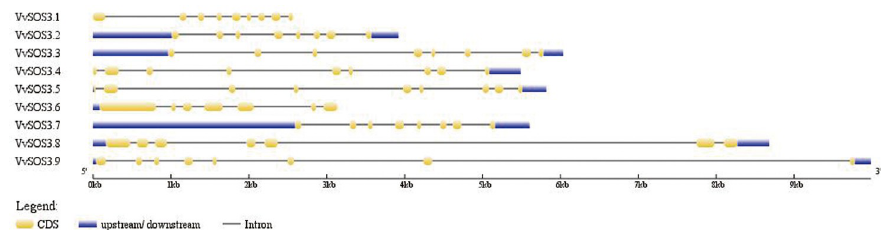
Fig 3. Diagrammatic illustration of exon/intron and UTR structure of thenine VviSOS3 genes. Gene IDs are indicated on the left. Regions of coding sequence (CDS) are represented by yellow boxes. Lines connecting CDS regions represent introns and untranslated regions (UTR) are represented by blue boxes. All of the designated regions are drawn to scale.